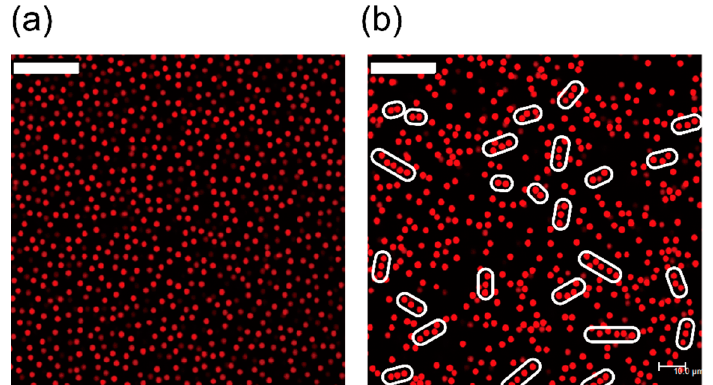
Figure 4. Chain-like cluster formation. ( a ) Schematic explanation of an effective potential acting on cells. The blue and red lines show the electrostatic repulsion and integrated van der Waals attractions, respectively; ( b ) The long-range nature of repulsive Coulomb interactions stabilized the chain by preventing the clusters from folding; ( c ) Ionic clouds surrounding cells may also play an important role in making the chain-like structure rigid.